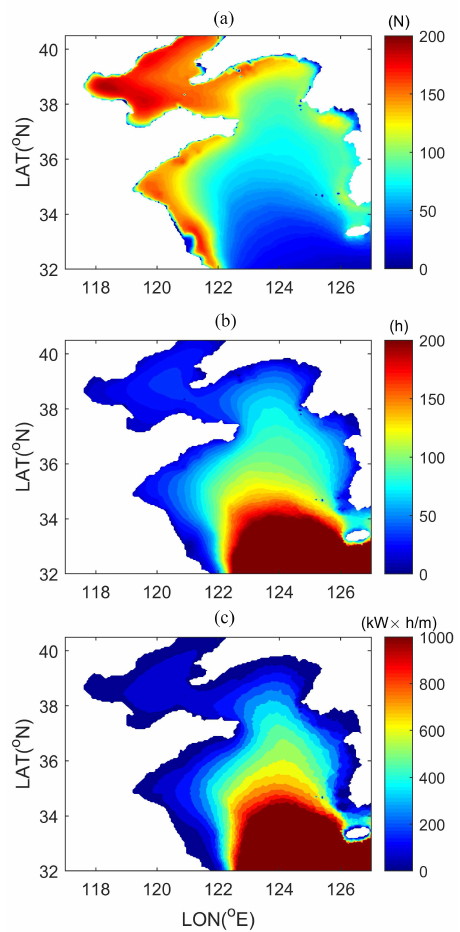
Figure 9. Mean parameters of the exploitable wave energy events during 1979–2018. ( a ) Annual mean wave energy event number; ( b ) wave energy event duration; ( c ) storage of exploitable wave